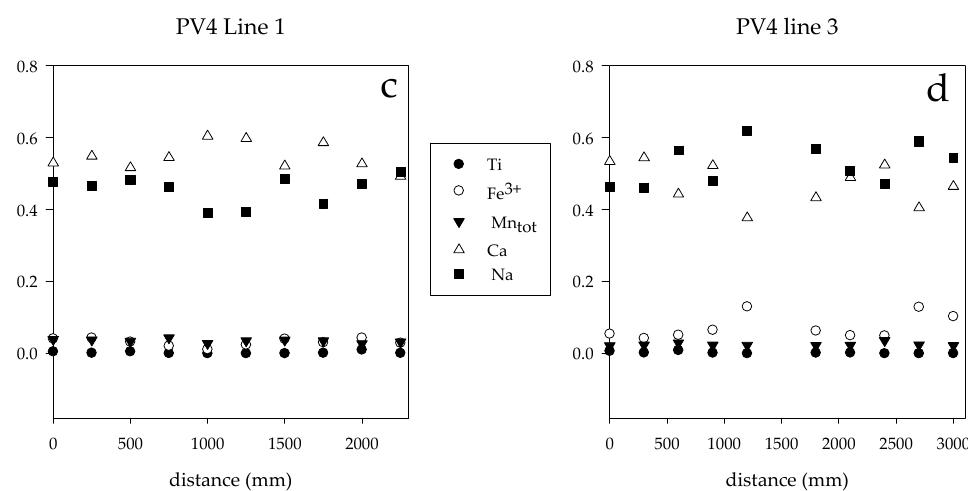
Figure 5. Optical microscope ( a ), BKSE ( b ) images, ( c , d ) zoning patters of different elements (apfu) along two lines of sample PV4.